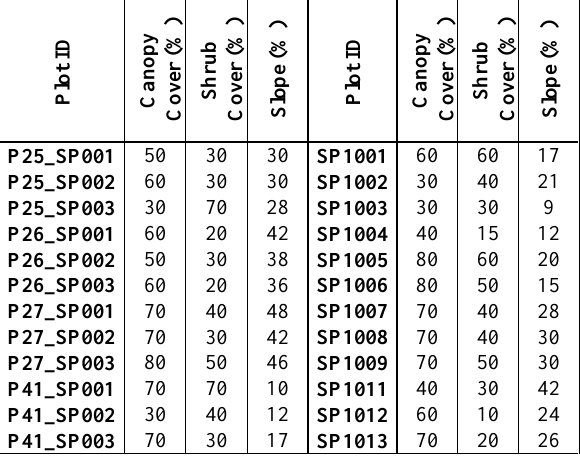
Figure 2. Examples of differences in the terrain slope and shrub cover, representing (a) a terrace of an old crop (yellow dashed line) with presence of shrubs, and (b) a steep terrain with absence of